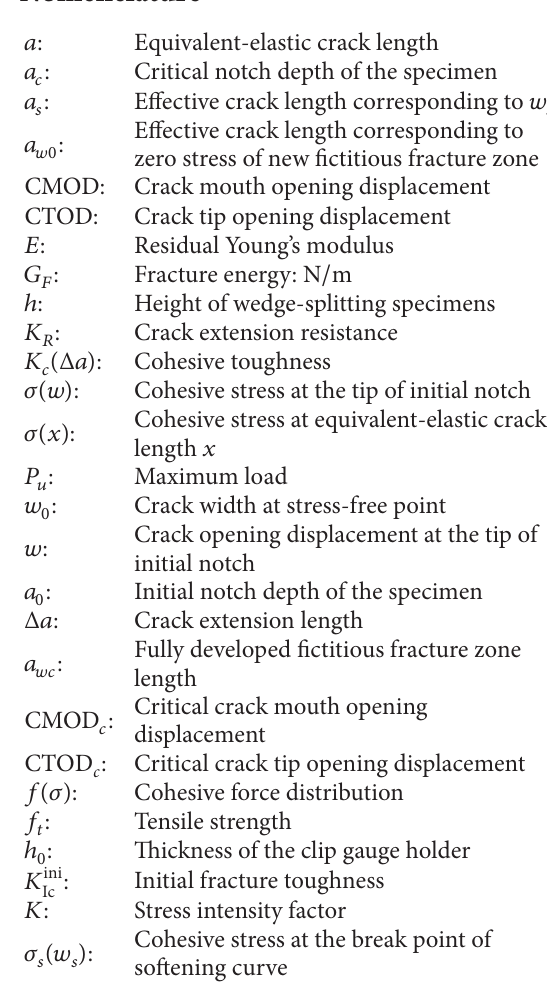
Figure 10: 𝐾 𝑅 -curves with crack extension length of all tempera-